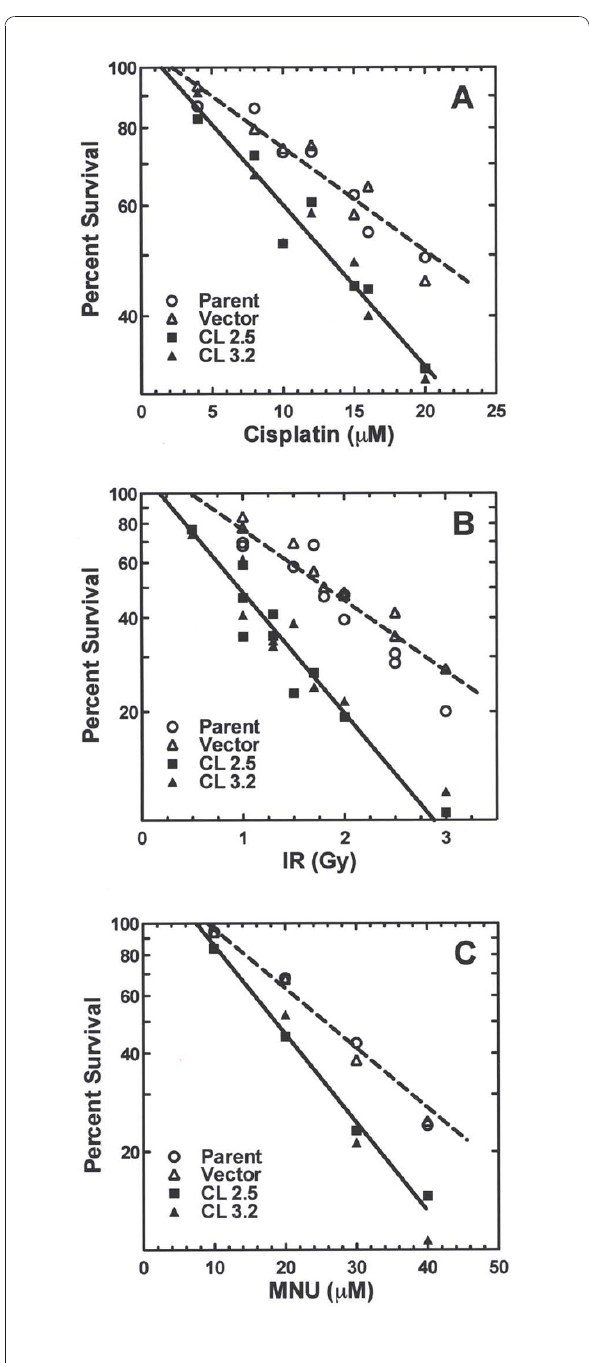
Figure 4 Reducing the level of hRev7 in human fibroblast cells renders them more sensitive to the cytotoxic effects of a variety of different types of DNA damaging agents . Cell strains 2.5 and 3.2, which have significantly reduced hRev7 protein, (closed symbols) were compared to their parental strain and the vector control strain (open symbols) for their sensitivity to the cytotoxic effects of (A) the DNA cross-linking agent cisplatin, (B) ionizing radiation (IR), and (C) the alkylating agent N -methyl- N -hydroxyurea (MNU). The lines represent the least squares regression for the